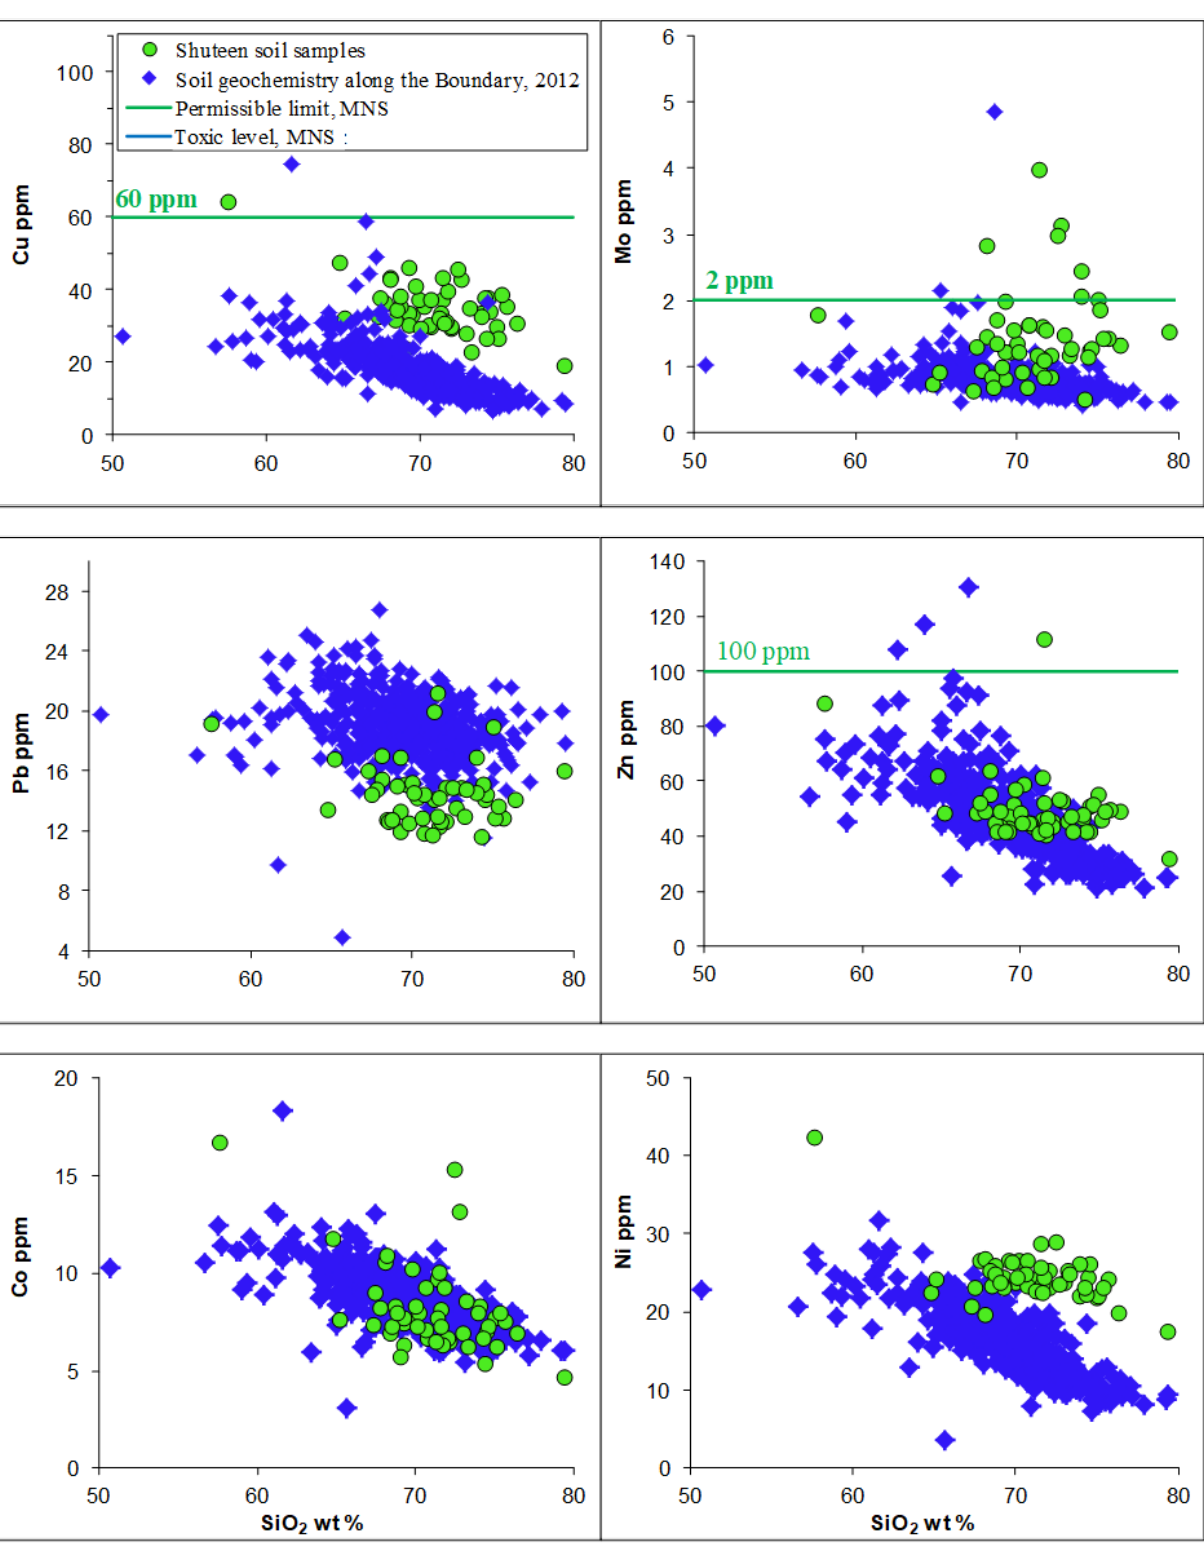
Fig. 4. Heavy metal contents vs SiO